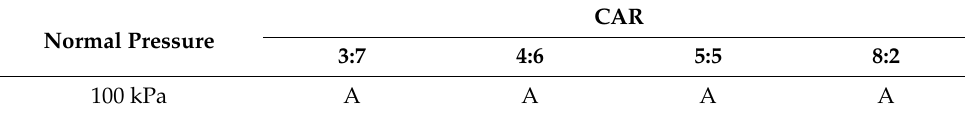
Table 5. Influence of CAR on shear strength.